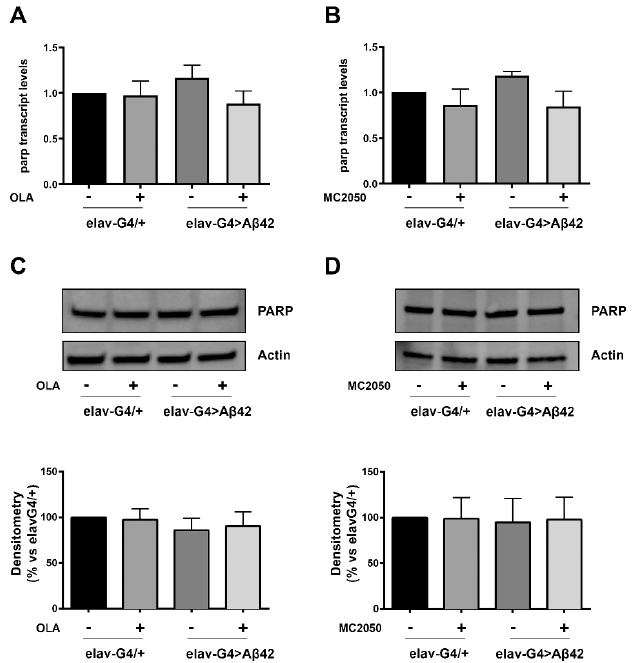
Figure 5. ( A ) and ( B ) qRT-PCR analysis assessing induction levels of PARP-1 transcript following olaparib ( A ) or MC2050 ( B ) treatments. cDNA was prepared from total RNA purified from AD ( elav-Gal4 > A β42 ) and control ( elav-Gal4/+ ) head tissues, treated (or not) with PARP-1 inhibitors. The constitutive rp49 was examined as an endogenous control. The data are expressed as “fold enrichment” with respect to elav-Gal4/+ and represent the mean ± SEM of three independent experiments. Statistical analysis, determined by unpaired t-test, showed no significant difference between means. ( C ) and ( D ) Western blot analysis of head protein extracts from elav-Gal4/+ and elav-Gal4 > A β42 flies, treated or not with olaparib ( C ) or MC2050 ( D ), probed with PARP-1 specific antibody. Densitometry analysis was performed using ImageLab software and normalized to Actin. The data are expressed as a percentage of the elavG4/+ control values and represent the mean ± SEM of at least three independent experiments. Two-way ANOVA followed by the Tukey test for multiple comparisons showed no significant differences among the means of the different groups.